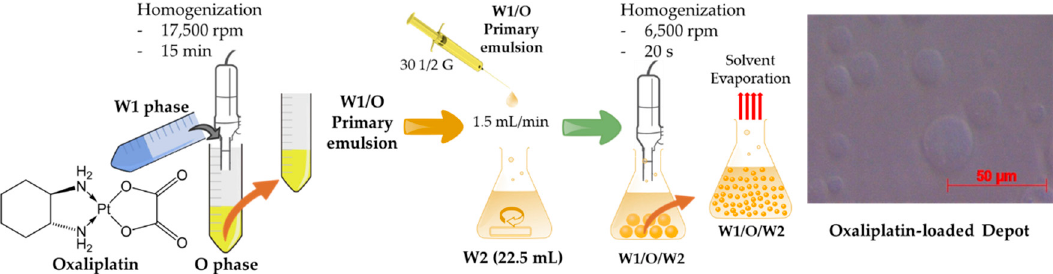
Figure 1. The structure of oxaliplatin, a schematic presentation of the multivesicular liposome (MVL) preparation, and an optical microscopy image of an oxaliplatin-loaded MVL depot.